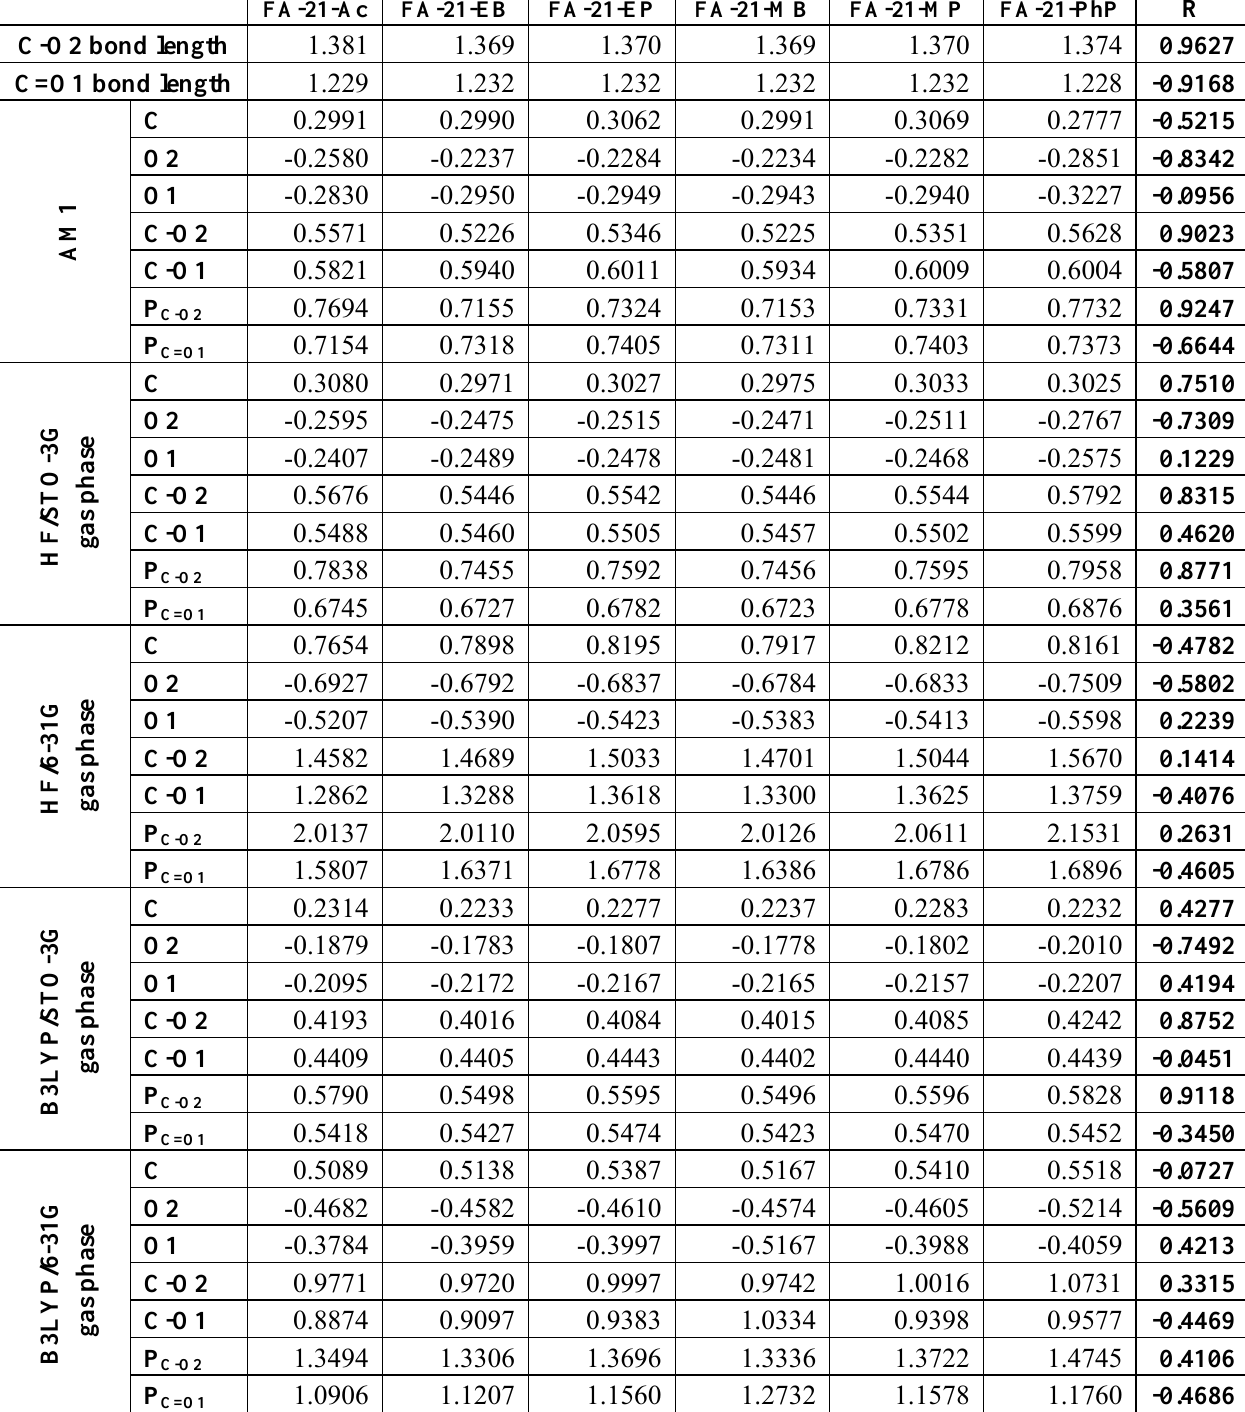
Table 1. Solvolytic rate constants (K) and descriptor